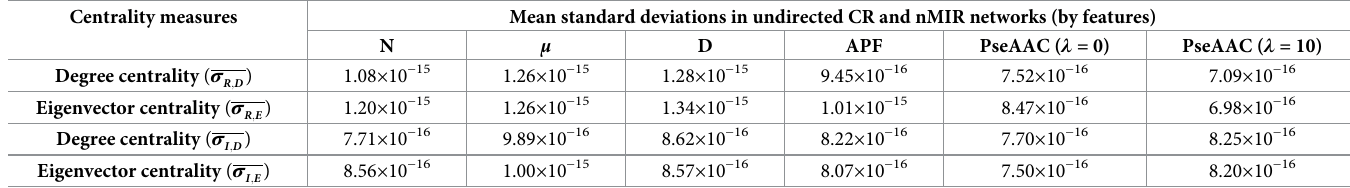
Table 1. The mean standard deviation results for the centralities of undirected networks (CATH). Centrality measures